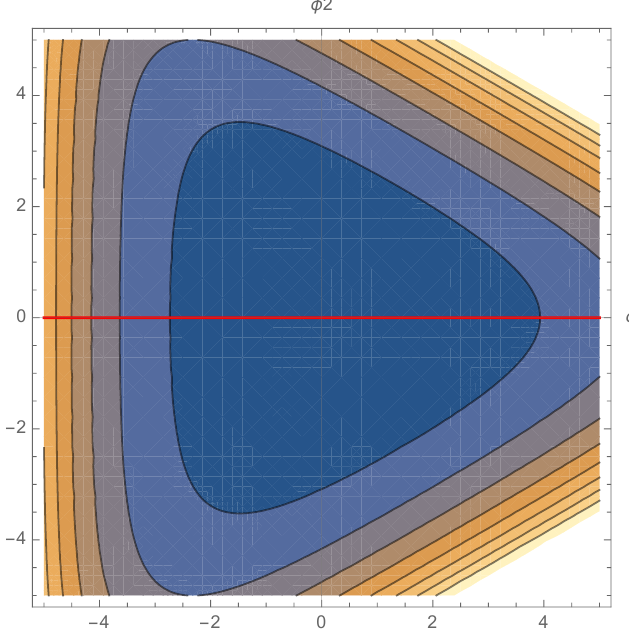
Figure 2 . The scalar potential. The red line denotes (cid:30) 2 =